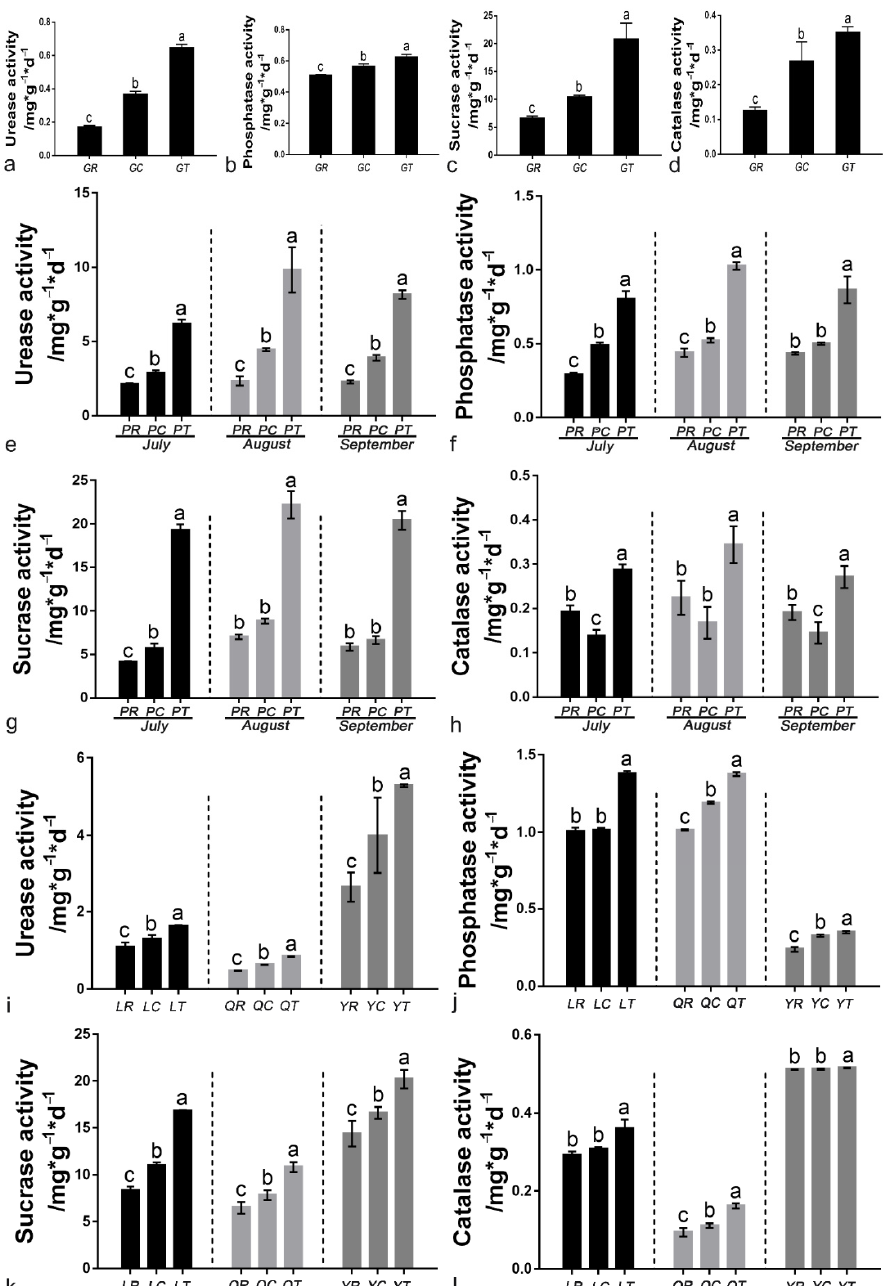
Figure 6. Soil urease activity in the greenhouse experiment ( a ), pot experiment ( e ), and field exper- iment ( i ); soil phosphatase activity in the greenhouse experiment ( b ), pot experiment ( f ), and field experiment ( j ); soil sucrase activity in the greenhouse experiment ( c ), pot experiment ( g ), and field experiment ( k ); and soil catalase activity in the greenhouse experiment ( d ), pot experiment ( h ), and field experiment ( l ). Different lowercase letters (a,b,c) in the same column indicate a significant difference at p ≤ 0.05 level by Duncan’s new multiple range